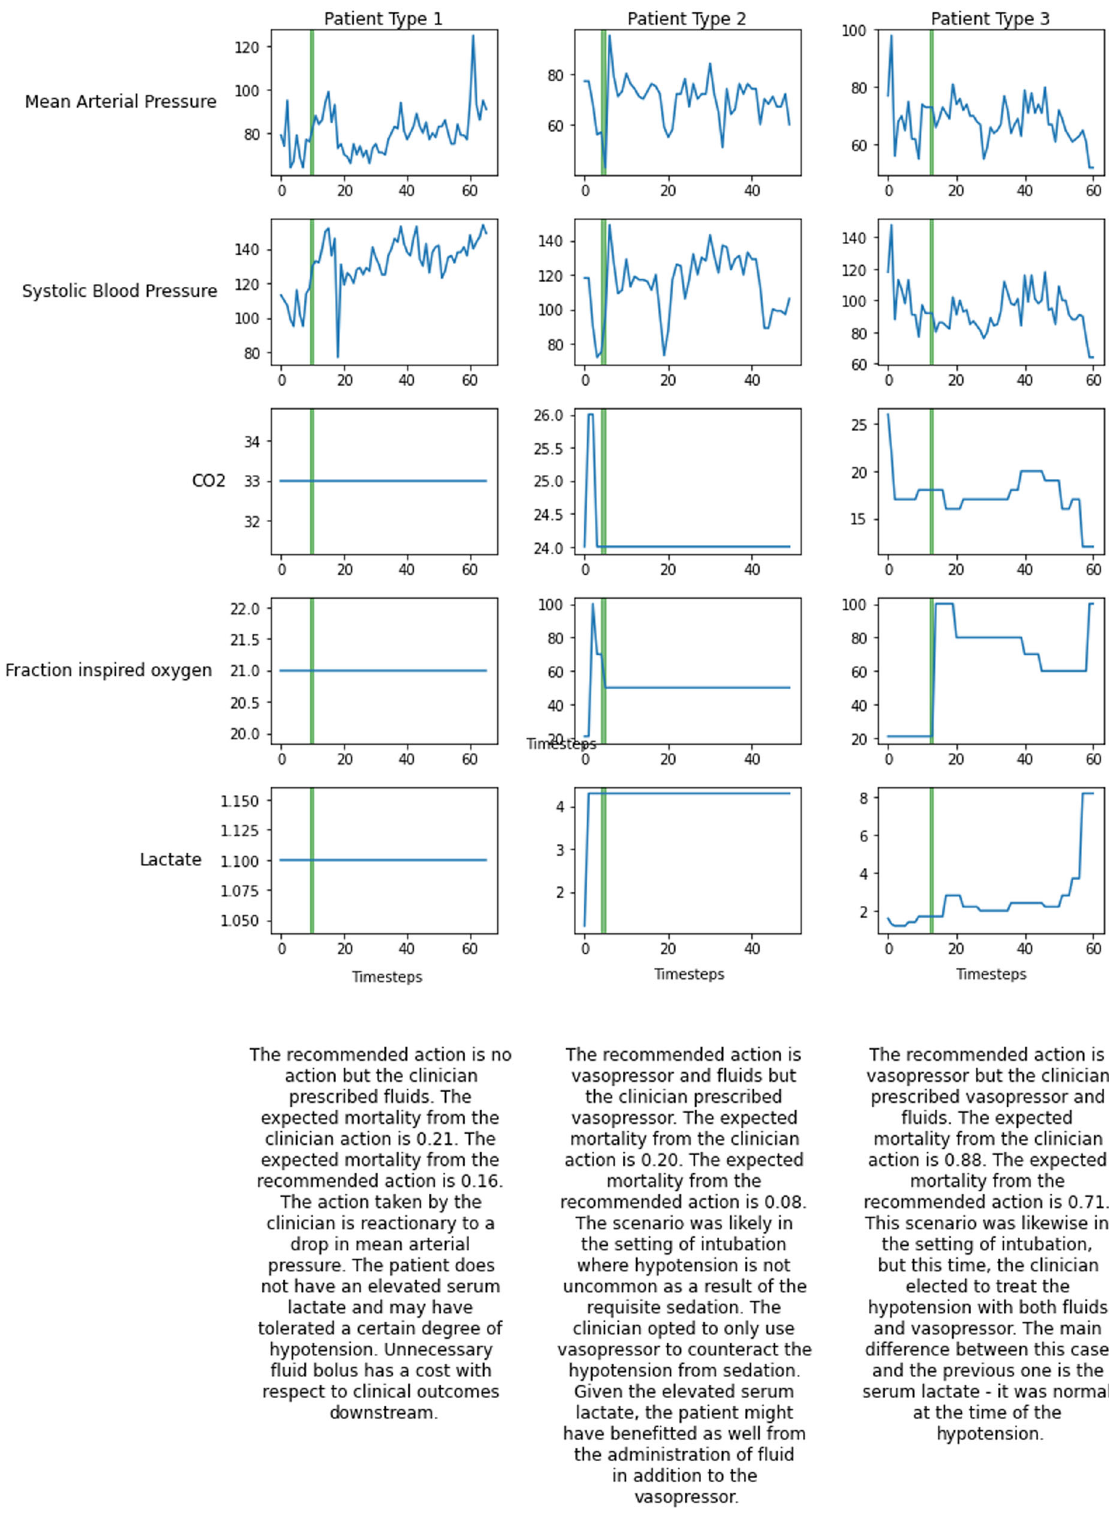
Fig. 5 Examples of patient trajectories. For three speci fi c patient cases where the recommended action differs from the clinician actions, we track the changes over time in their clinical